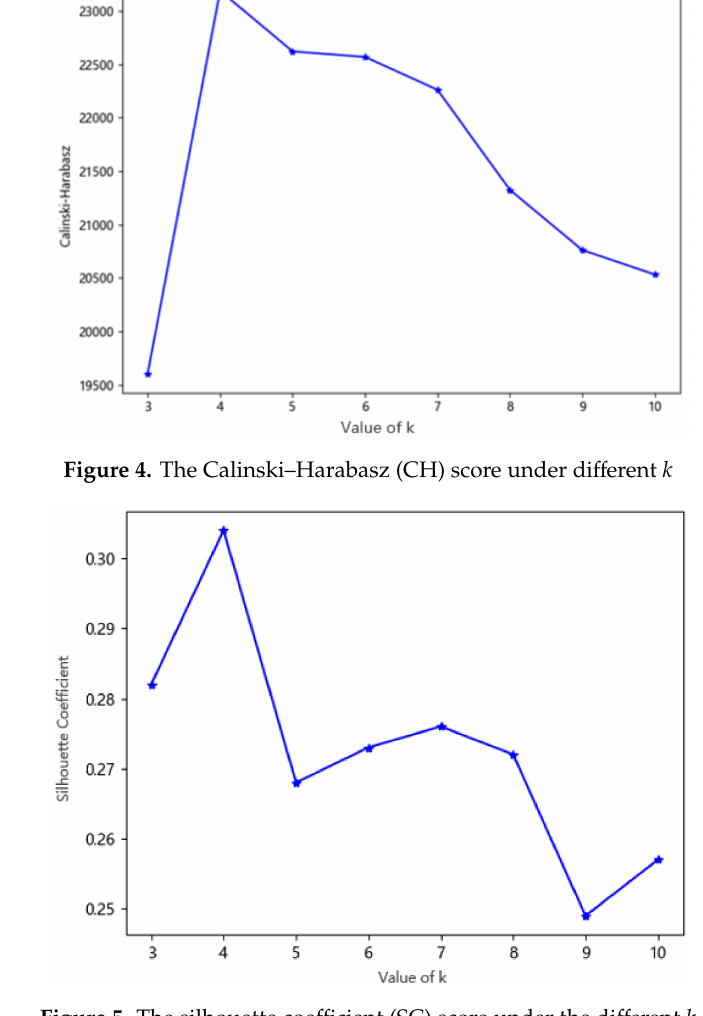
Figure 5. The silhouette coe ffi cient (SC) score under the di ff erent